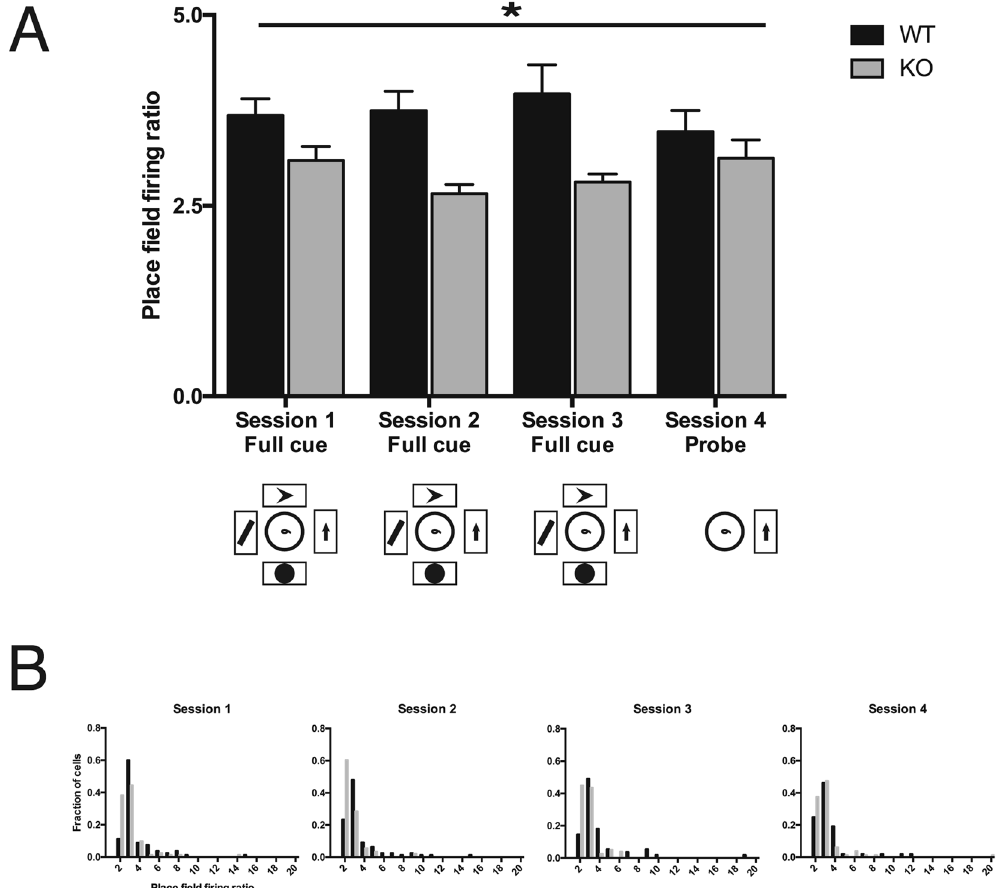
Figure 2. Spatial specificity of place cells per session. ( A ) Place field firing rate increase of WT (black) and Fmr1 -KO (gray) pyramidal cells within their respective fields, relative to the firing rate of each cell outside its field (the place field firing ratio). Data are represented as mean ± SEM. Session 1: WT 80 cells, mean = 3.69, SEM = 0.22; KO 81 cells, mean = 3.09, SEM = 0.18. Session 2: WT 77 cells, mean = 3.75, SEM = 0.25; KO 91 cells, mean = 2.66, SEM = 0.12. Session 3: WT 55 cells, mean = 3.97, SEM = 0.38; KO 78 cells, mean = 2.81, SEM = 0.10. Session 4: WT 52 cells, mean = 3.47, SEM = 0.28; KO 80 cells, mean = 3.12, SEM = 0.24. ( B ) Distributions of place field firing rate increase of WT (black) and Fmr1 -KO (gray) pyramidal cells within their respective fields, relative to the firing rate of each cell outside its field (the place field firing ratio). * P < 0.0001 main effect of genotype (two-way genotype x session ANOVA: F 1,586 = 25.55). There was no effect of session and no interaction